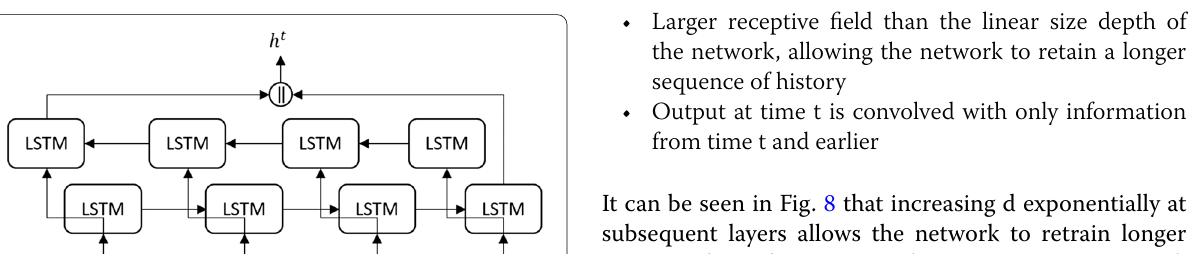
Fig. 5 Diagram illustrating the LSTM architecture. The tanh and σ gates are hidden layers with sigmoid activation function, pair-wise addition and multiplication operators, respectively. At the same time, the || connections are vector concatenation operators